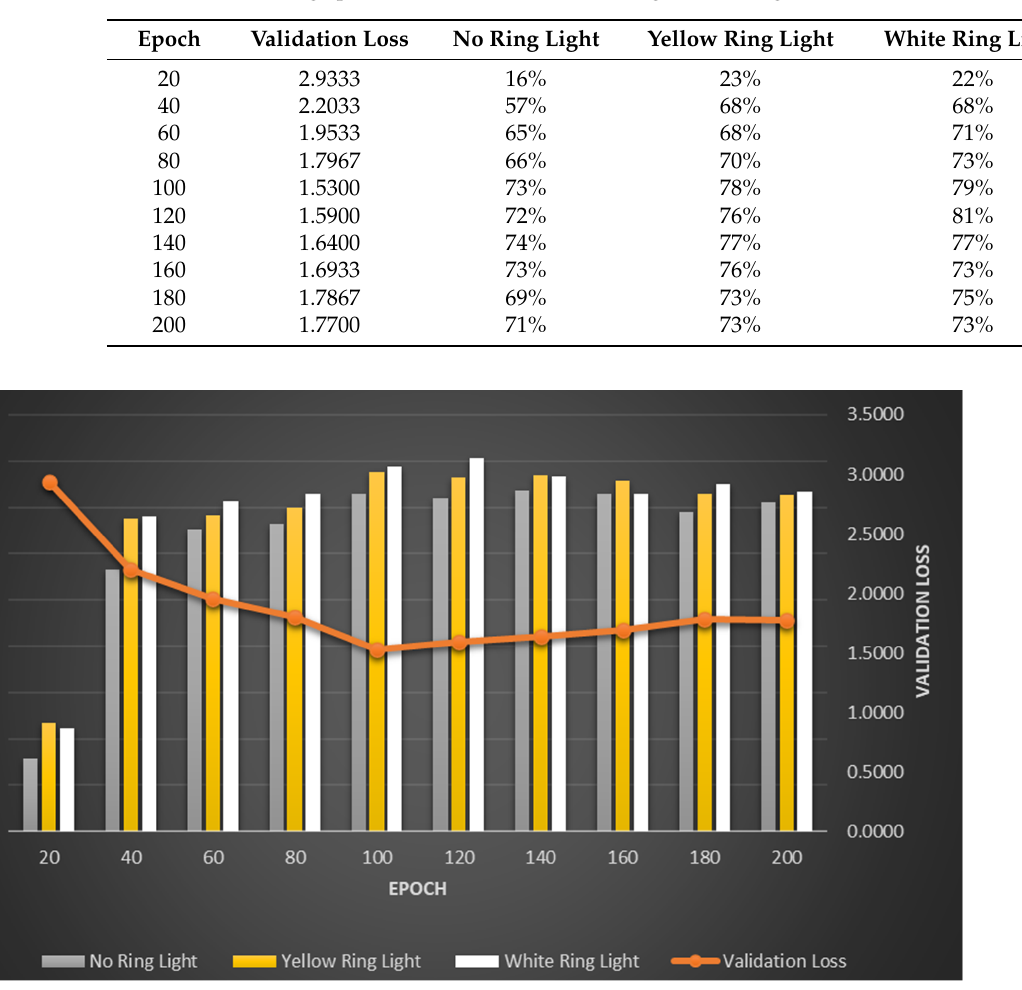
Table 4. Mean average precision table with values using different light sources.